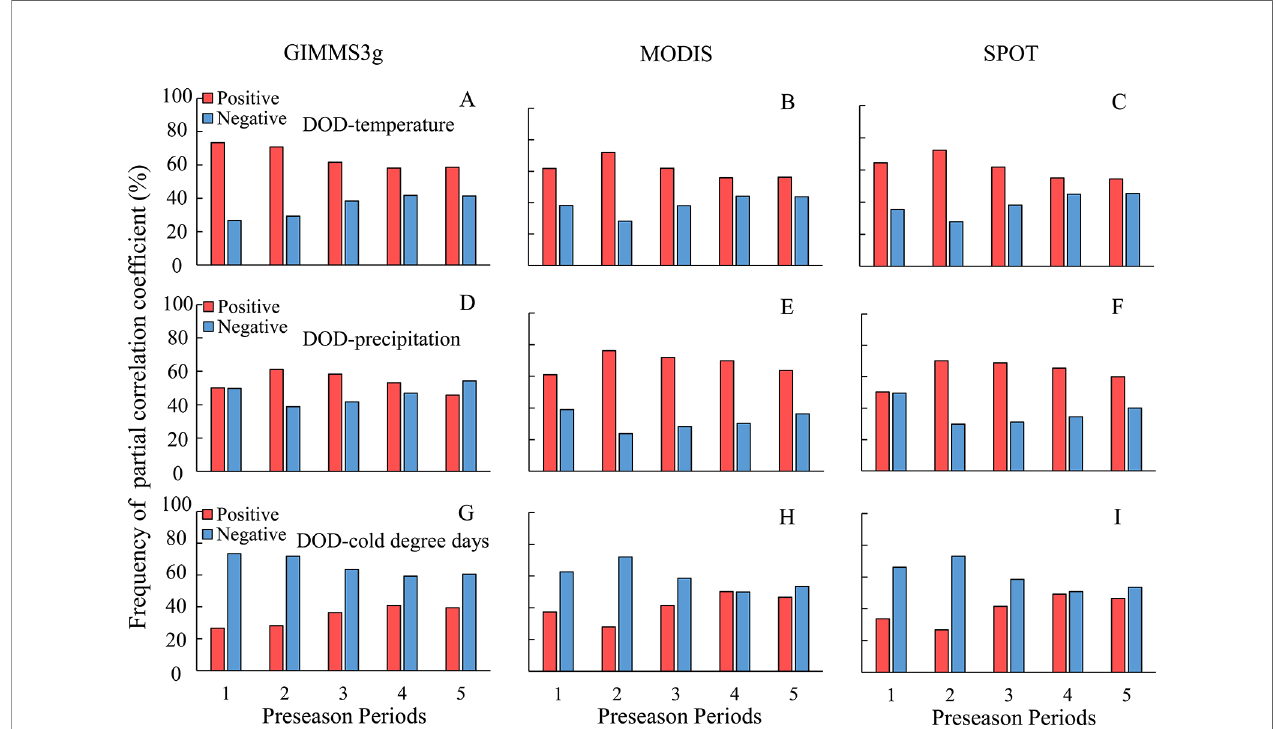
FIGURE 5 | Frequency distribution of the partial correlation coef fi cient between two methods averaged vegetation DOD of GIMMS3g, MODIS, SPOT, and climatic factors for different preseason periods. (A – C) for temperature, (D – F) for precipitation, (G – I) for cold degree